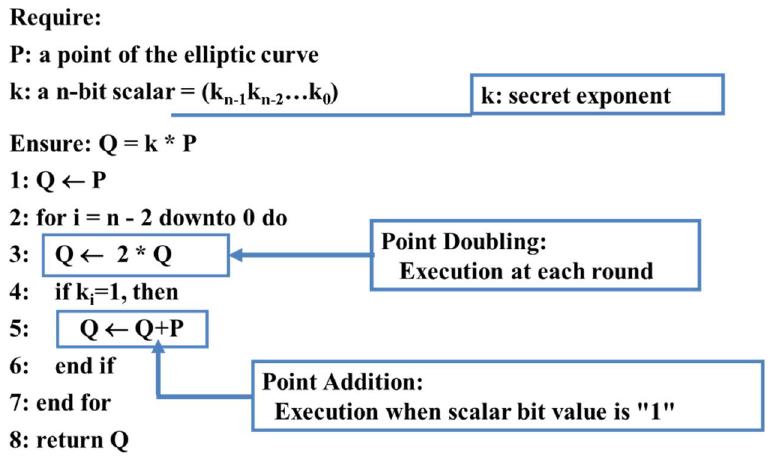
Figure 2. The most usual “Double and Add” algorithm for scalar multiplication.